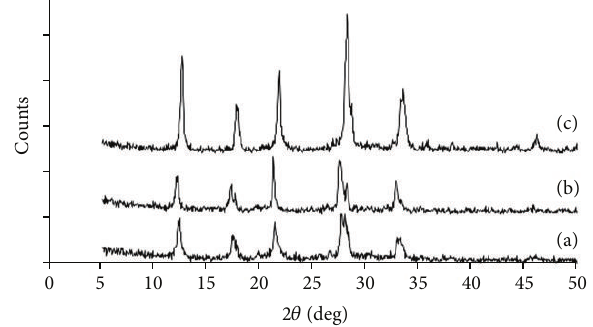
Figure 3: X-ray patterns of synthesized P zeolites after different crystallization times: (a) 30 h, (b) 40h, and (c) 60h.